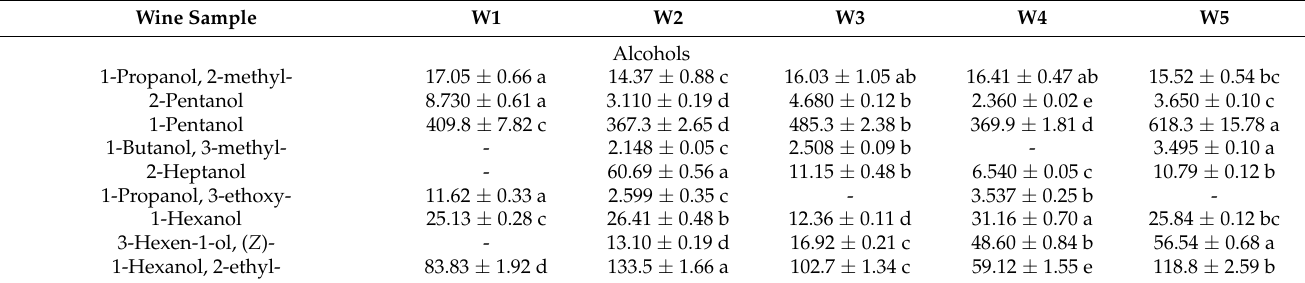
Table 6. Contents of the major volatile compounds in black chokeberry wines made by different brewing technologies